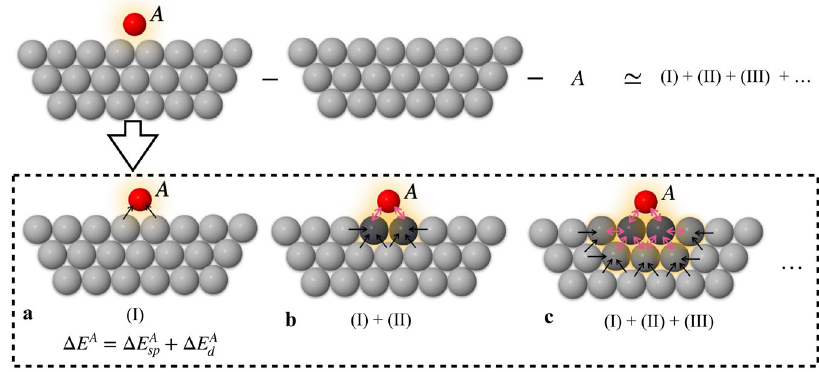
Fig. 4 Schematic illustration of adsorbate-surface interaction. The top panel shows a general representation of the adsorbate-surface interaction. In the bottom panel, a shows the zeroth order approximation to bonding which is based on the assumption that the adsorbate induces no changes in the surface electronic states and hence, that interaction is fully governed by the changes induced in the adsorbate states. b , c Introduce fi rst and second order effects, respectively. Here the double headed pink arrows indicate that the interaction perturbs the states at both ends, leading to explicit changes in the interaction with the surroundings as indicated by the black arrows. The change in color scale (dark to light gray) indicates the decreasing interaction away from the adsorption